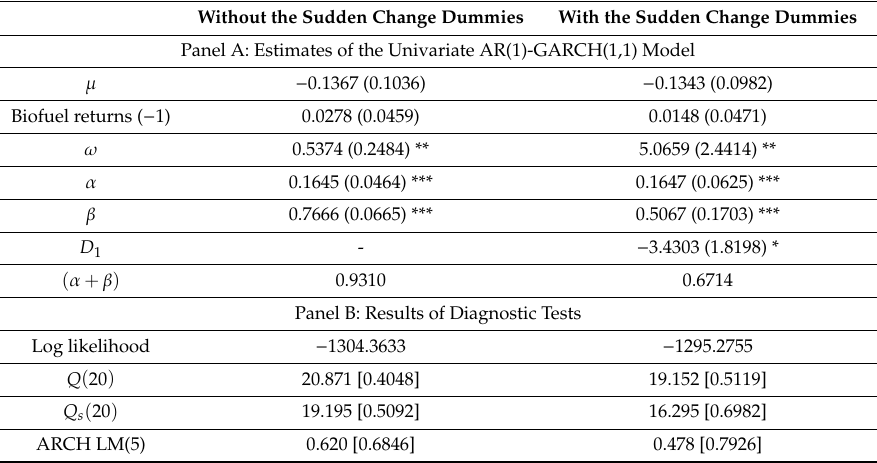
Table 4. Estimation results of AR(1)-GARCH(1,1) model for the Biofuel returns. Without the Sudden Change Dummies